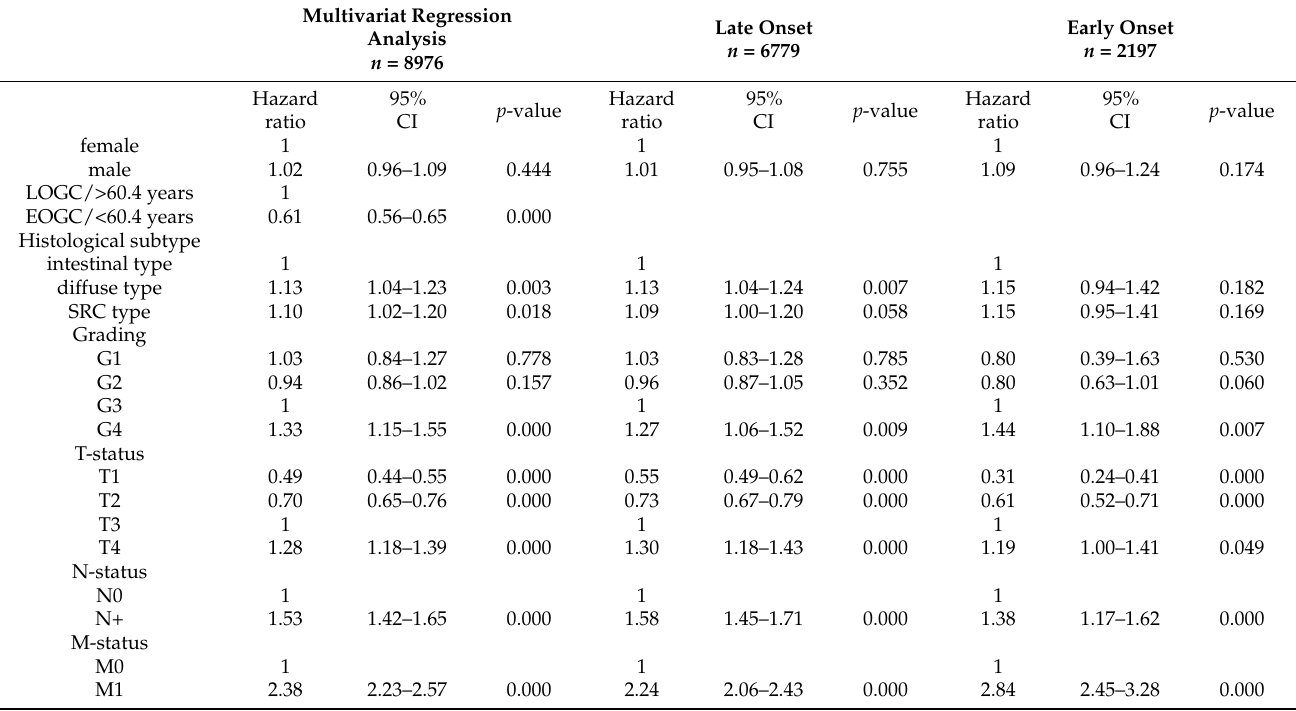
Table 3. Multivariate Cox regression analyses on the entire patient population, including only patients with adenocarcinoma